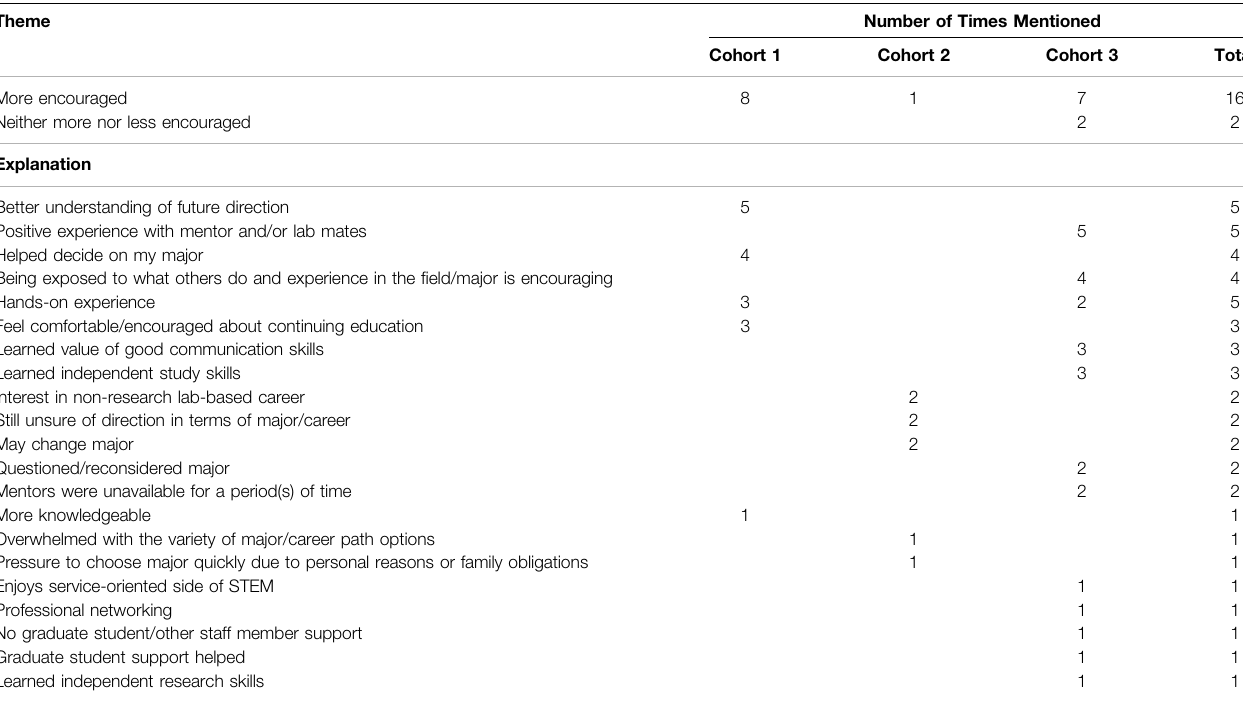
TABLE 7 | Themes mentioned in the focus group discussion in response to Question